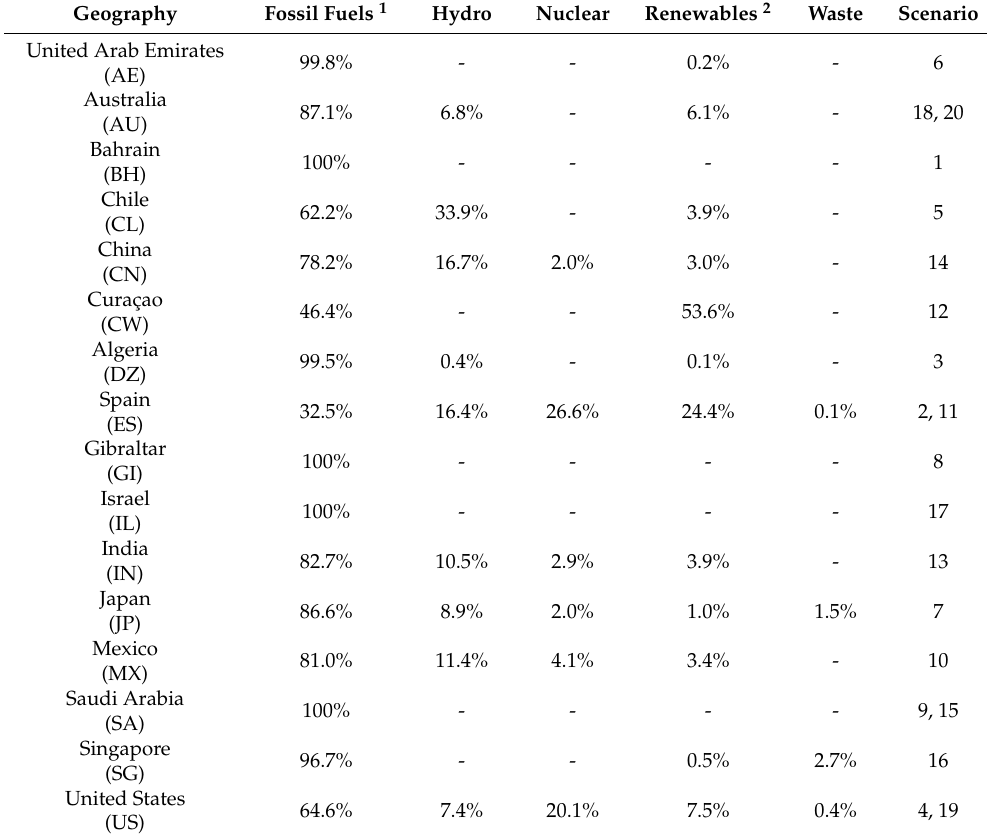
Table A1. Local electricity supply mix including imports. Data from